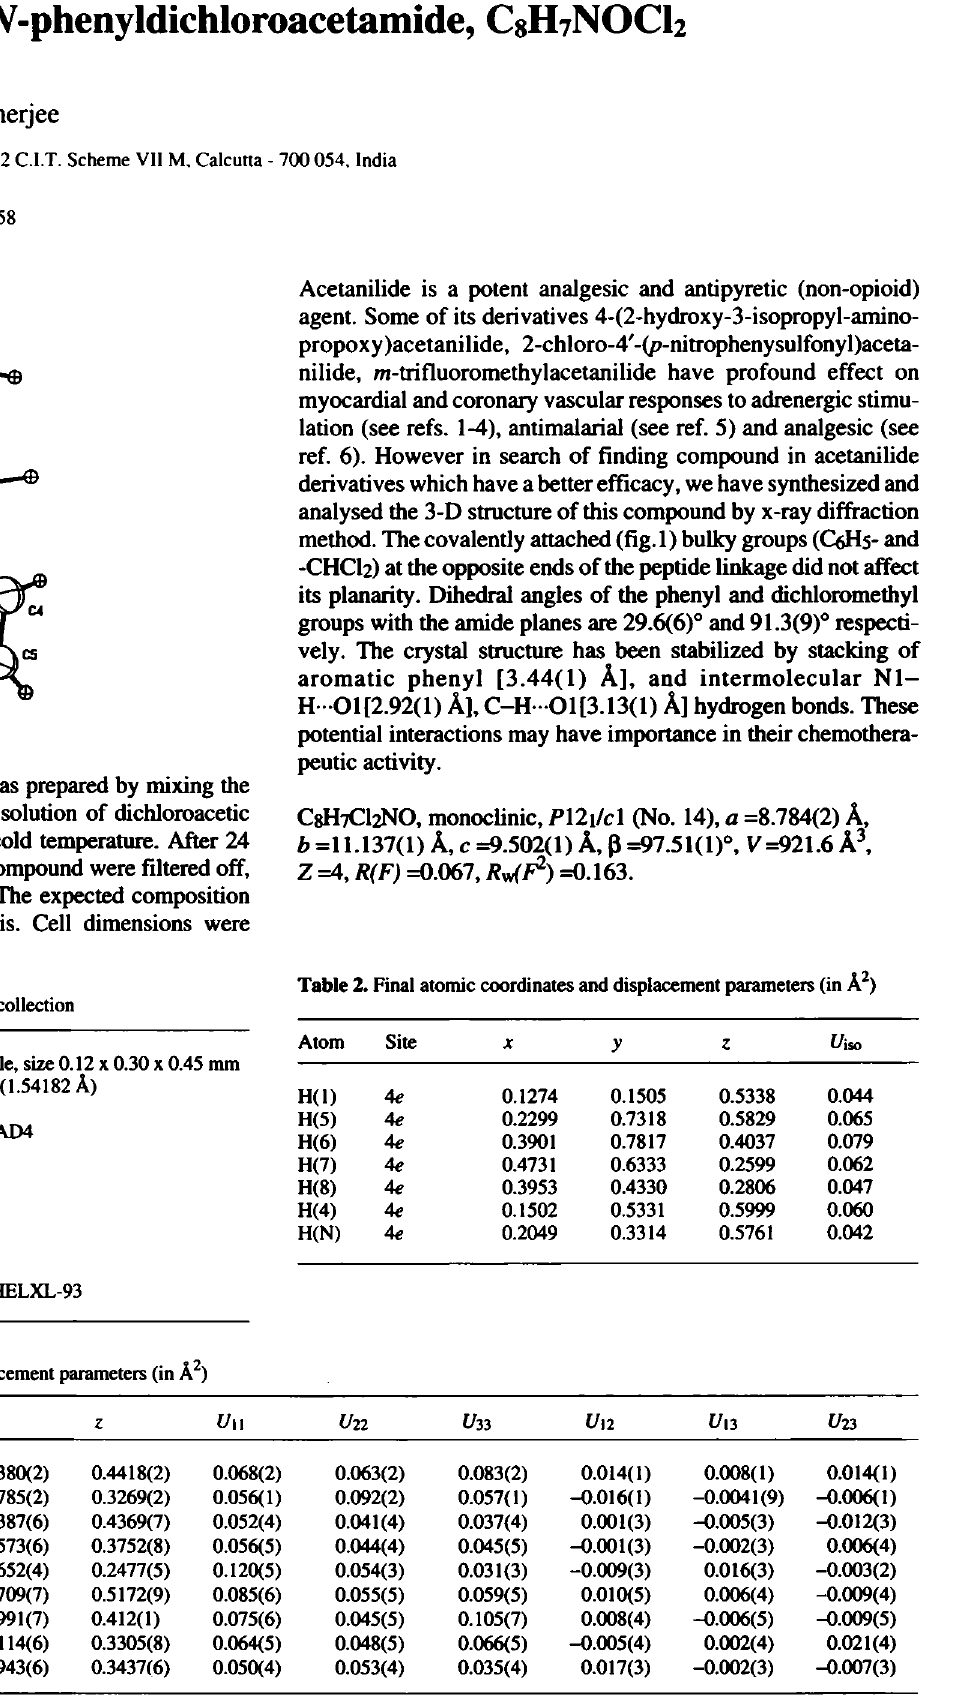
Table 3. Final atomic coordinates and displacement parameters (in }?)